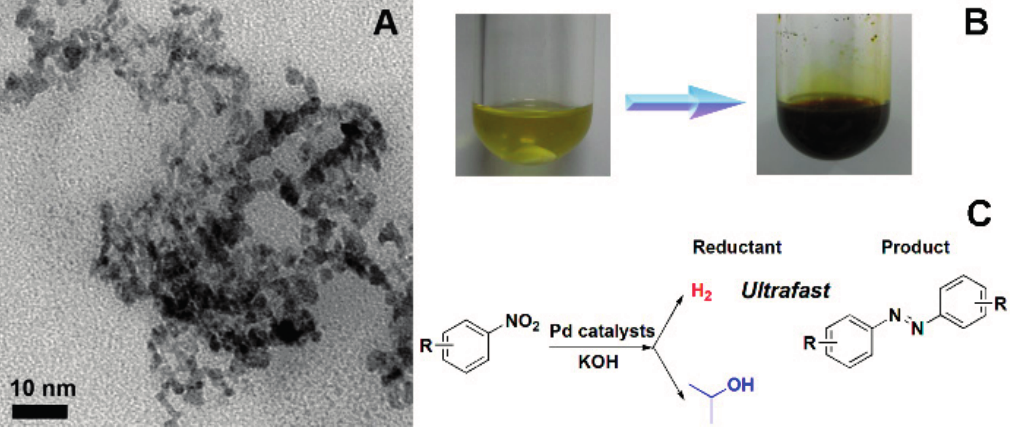
Figure 10. ( A ) The TEM image of Pd nanoclusters generated in situ ; ( B ) The optical image of reactions before and after the formation of aromatic azo compounds; ( C ) The formation of aromatic azo compounds using Pd nanoclusters generated in situ as catalysts